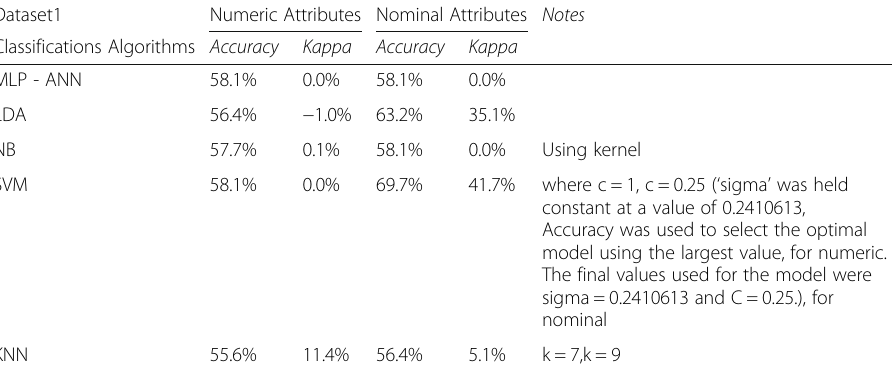
Table 8 Accuracy and Kappa results for nominal & numeric attributes for dataset 1 Dataset1